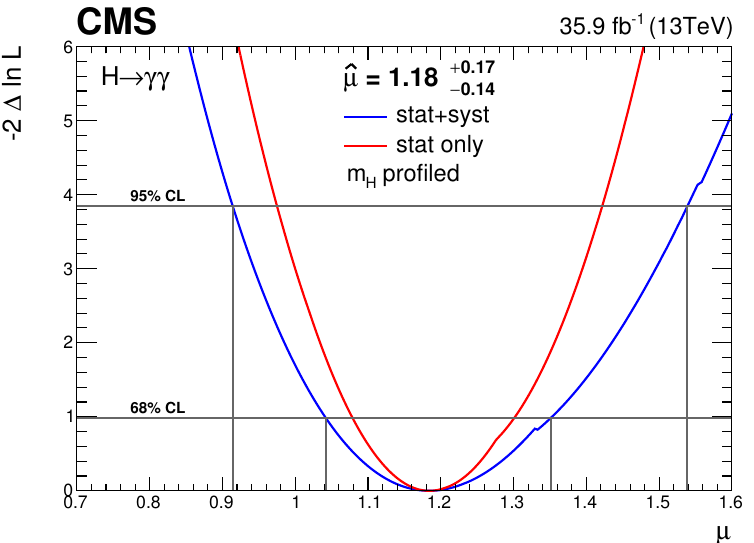
Figure 16 . The likelihood scan for the signal strength modi(cid:12)er where the value of the SM Higgs boson mass is pro(cid:12)led in the (cid:12)t.